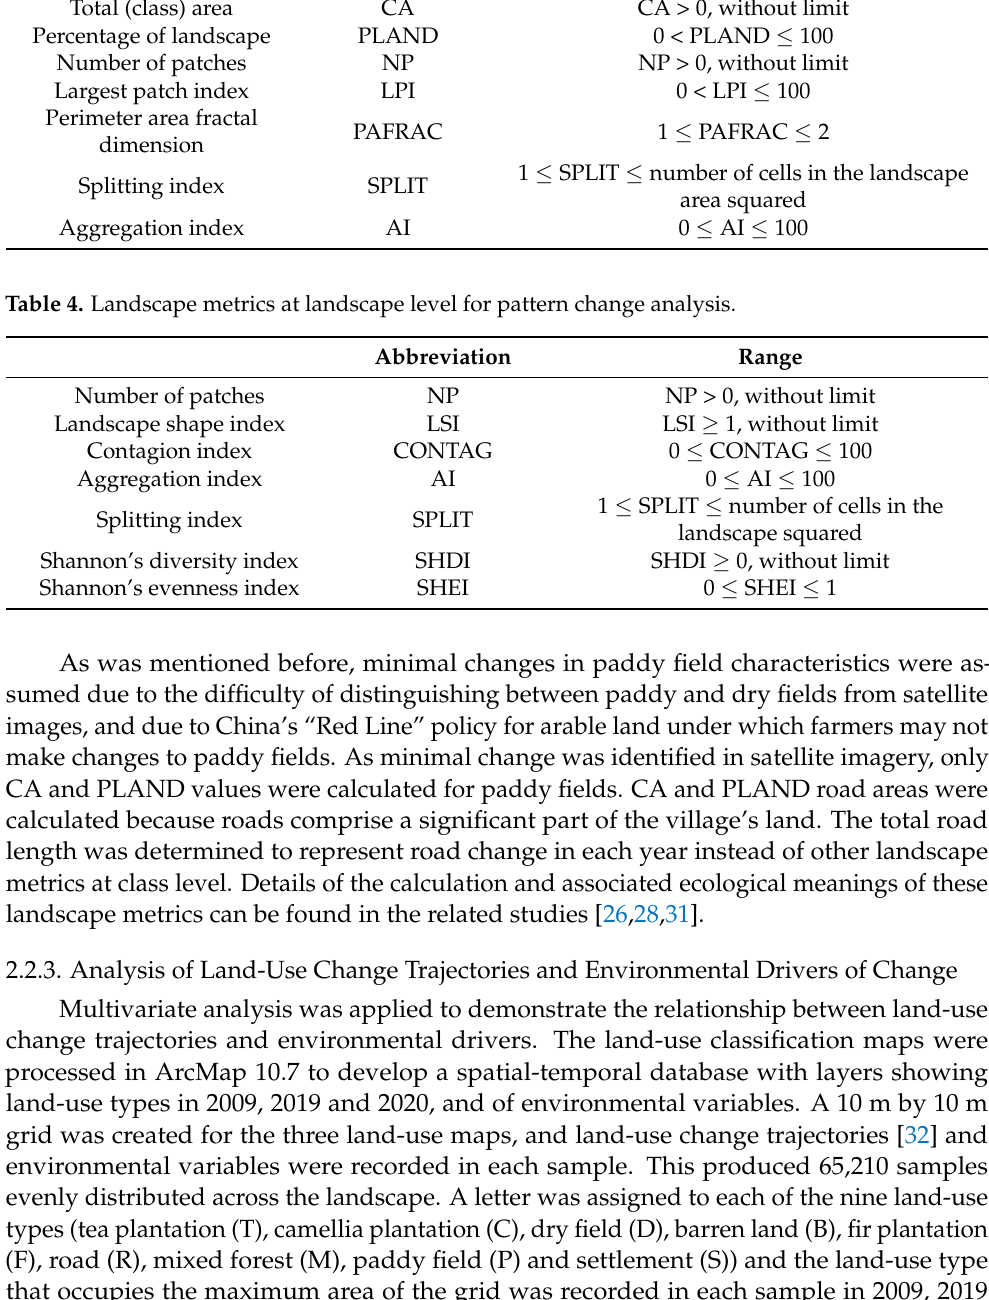
Table 3. Landscape metrics at class level for land-use change analysis. Abbreviation Range